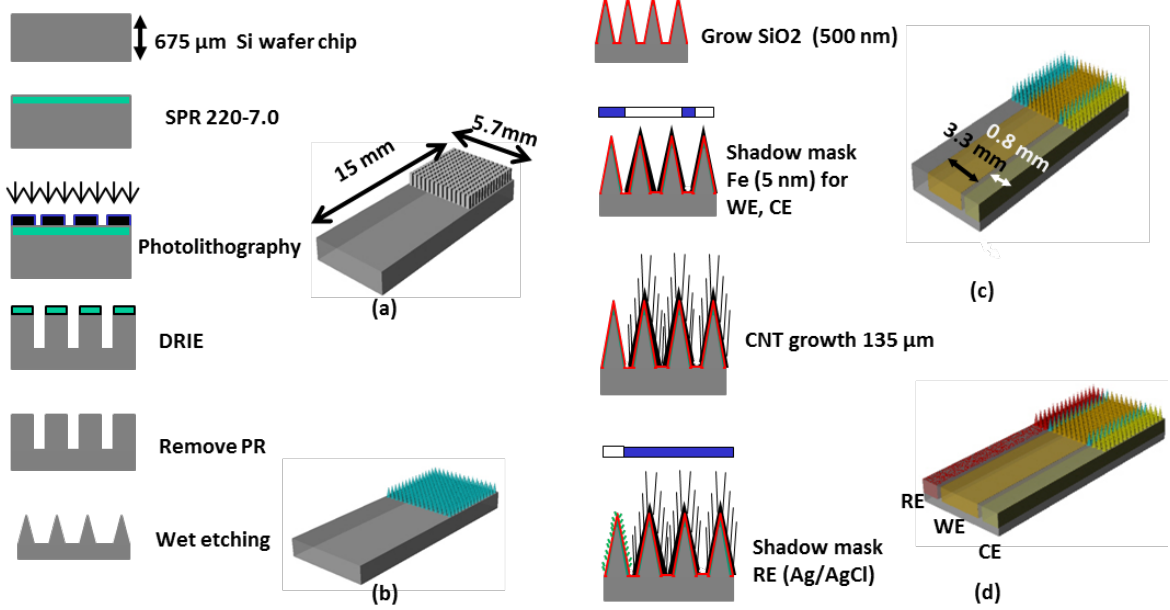
Figure 1. Fabrication sequence of the 3-electrode non-enzymatic microneedle-based glucose sensor ( a ) deep reactive ion etching of silicon to form rectangular pillar array; ( b ) wet etching of the rectangular pillar Si array to make sharp Si needle array; ( c ) iron deposition through a shaodw mask and MWCNT growth followed by Pt nano-particles electroplating; and ( d ) Ag deposition through a shadow mask and formation of Ag/AgCl reference